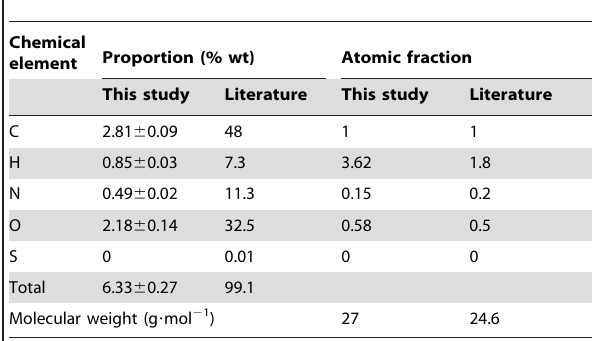
Table 1. Elemental analysis of a washed sample of C. hydrogenoformans culture grown on DSMZ medium compared to biomass elemental composition from literature